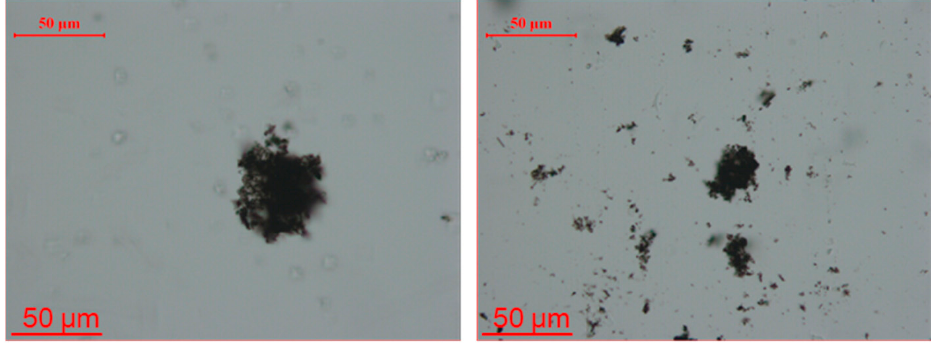
Figure 7. Microphotographs of kerogen of Wufeng-Longmaxi Formation in Well A.